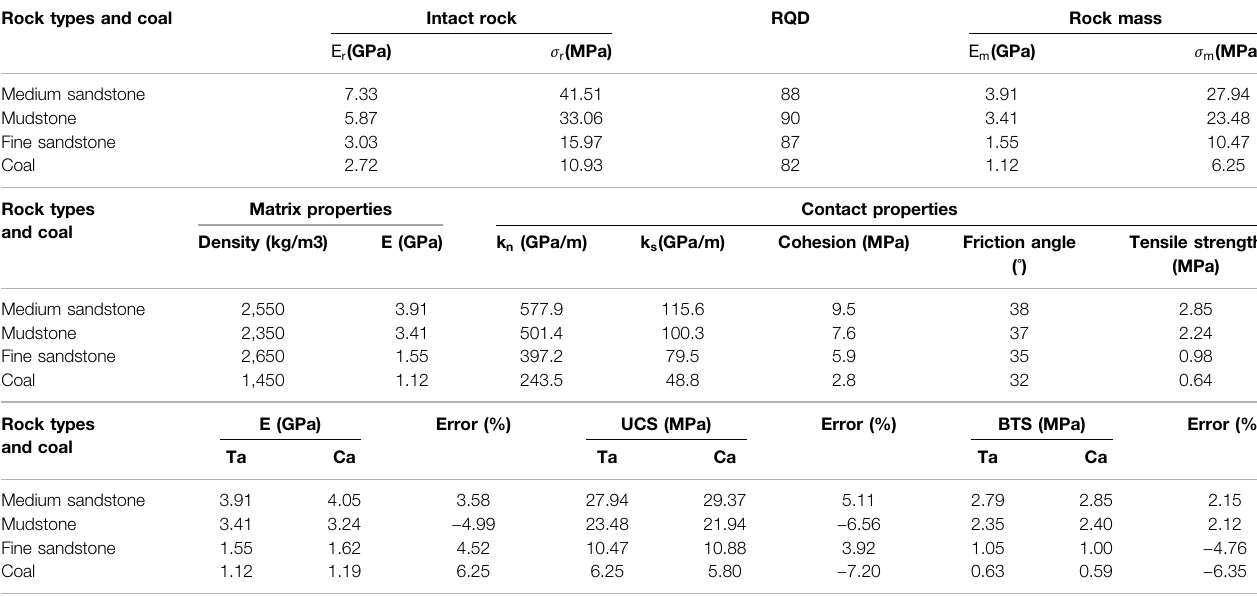
TABLE 1 | Intact rock, rock mass, and mechanical